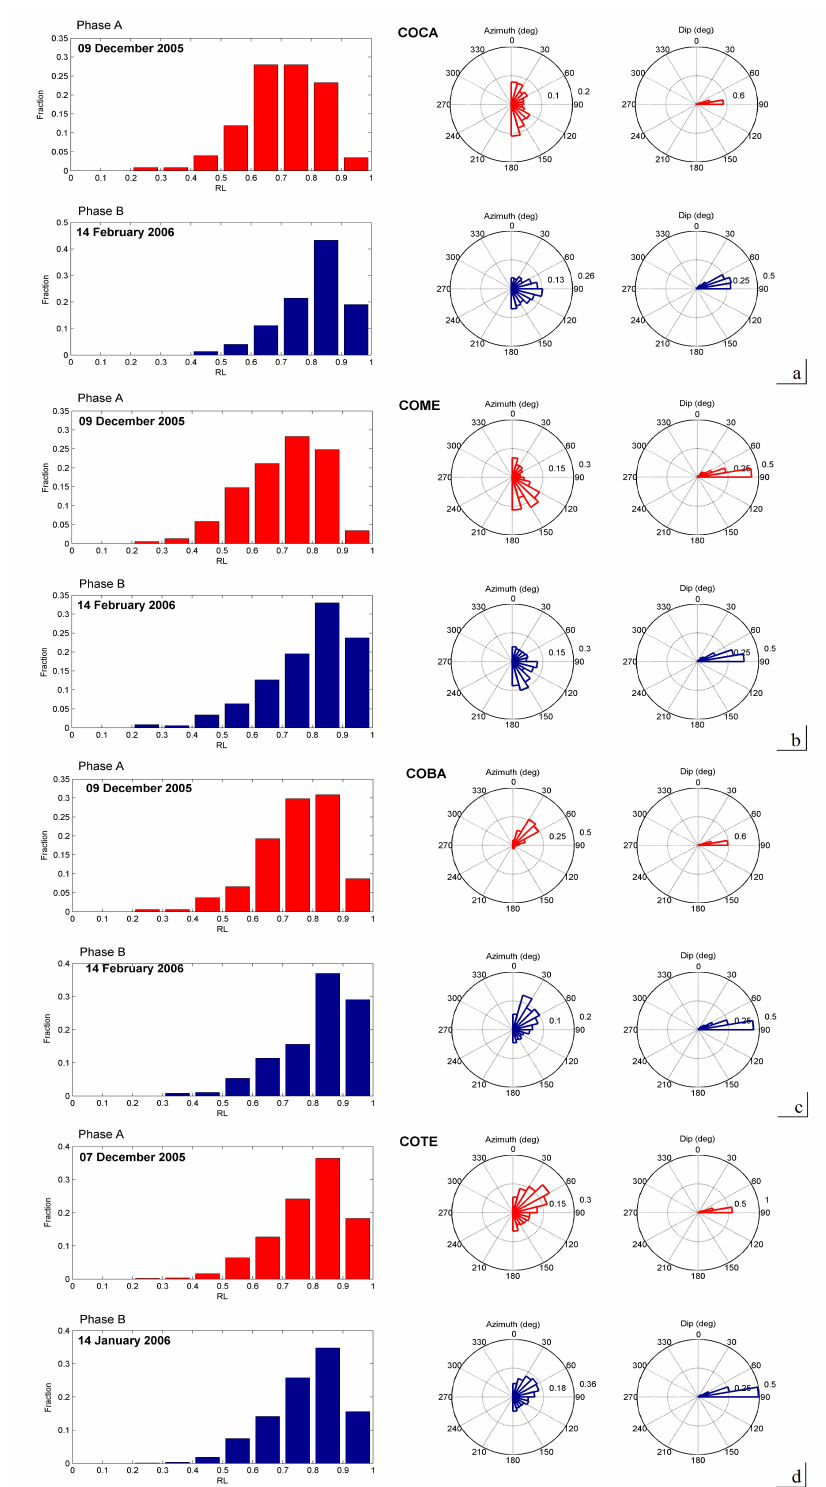
Fig. 8. Examples of polarization analysis for (a) COCA, (b) COME, (c) COBA, (d) COTE, in Phase A (red histograms) and in Phase B (blue histograms). For each station, the panel on the left contains the distribution of RL fraction; the central panel displays the azimuth distribution; the right graphic shows the dip